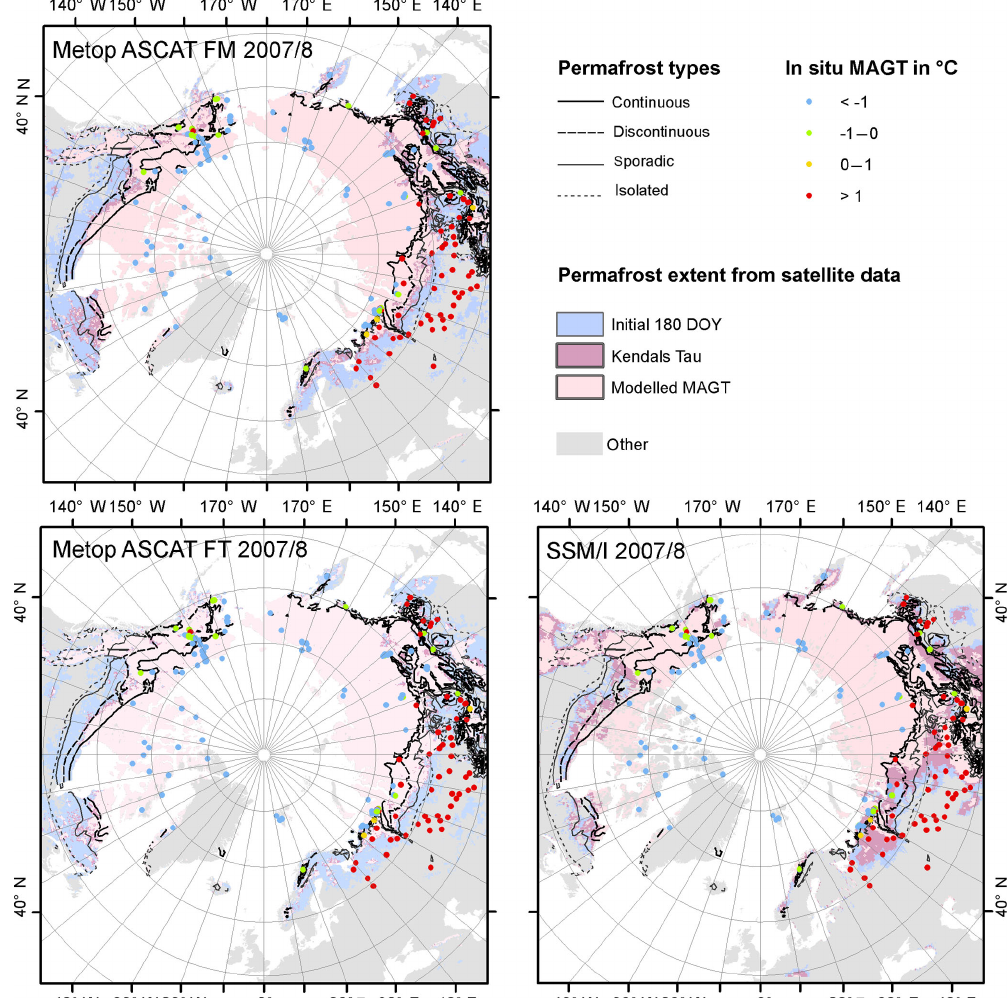
Figure 6. Permafrost extent maps based on thresholds applied to frozen days per year (DOY) for ASCAT excluding melt days (FT), thresholds applied to frozen days per year (DOY) for ASCAT including melt days (FM), and thresholds applied to frozen days per year (DOY) for SSM/I. The initial threshold is 180 days. The value for the best Kendall’s τ represents the best fit with borehole measurements. The highest threshold has been determined using an empirical model calibrated with borehole measurements. See also Table 1. All satellite results are based on 2007/2008–2008/2009 records. Source for permafrost extent classes is Brown et al.